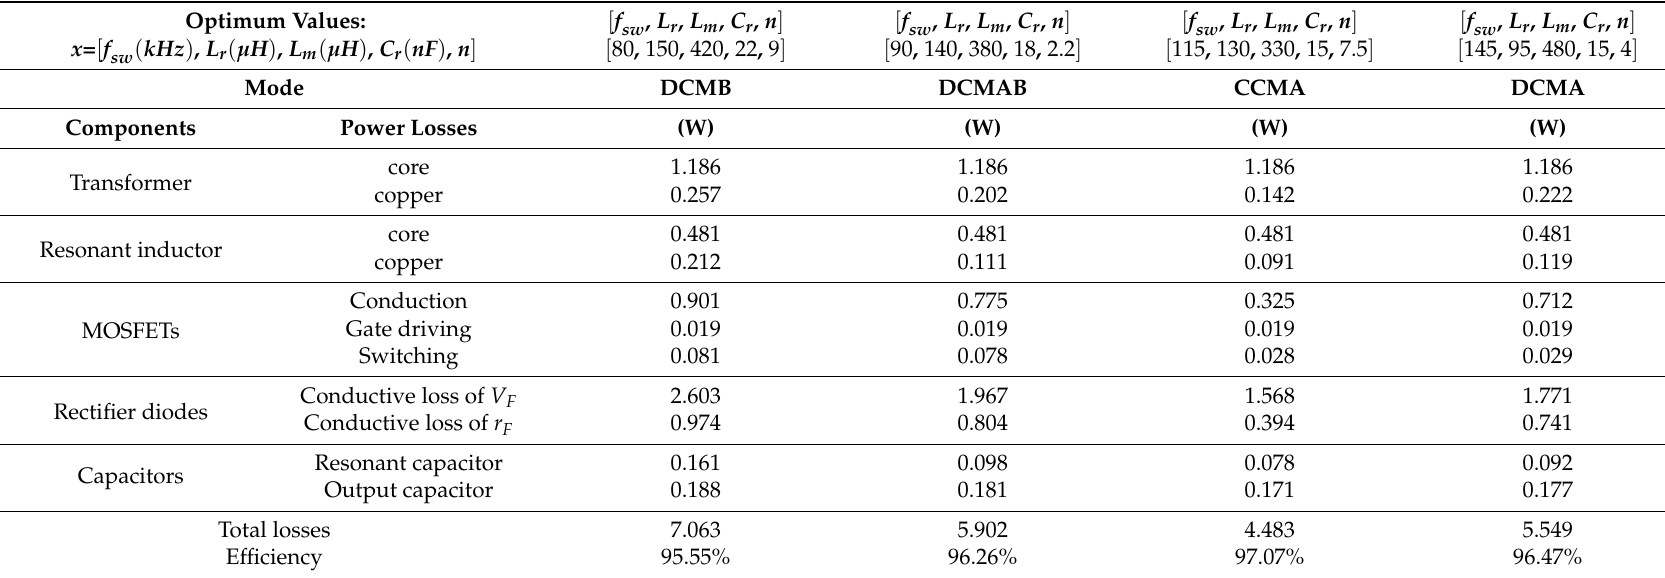
Table 5. Losses Profile of LLC resonant converter by Lagrangian optimization